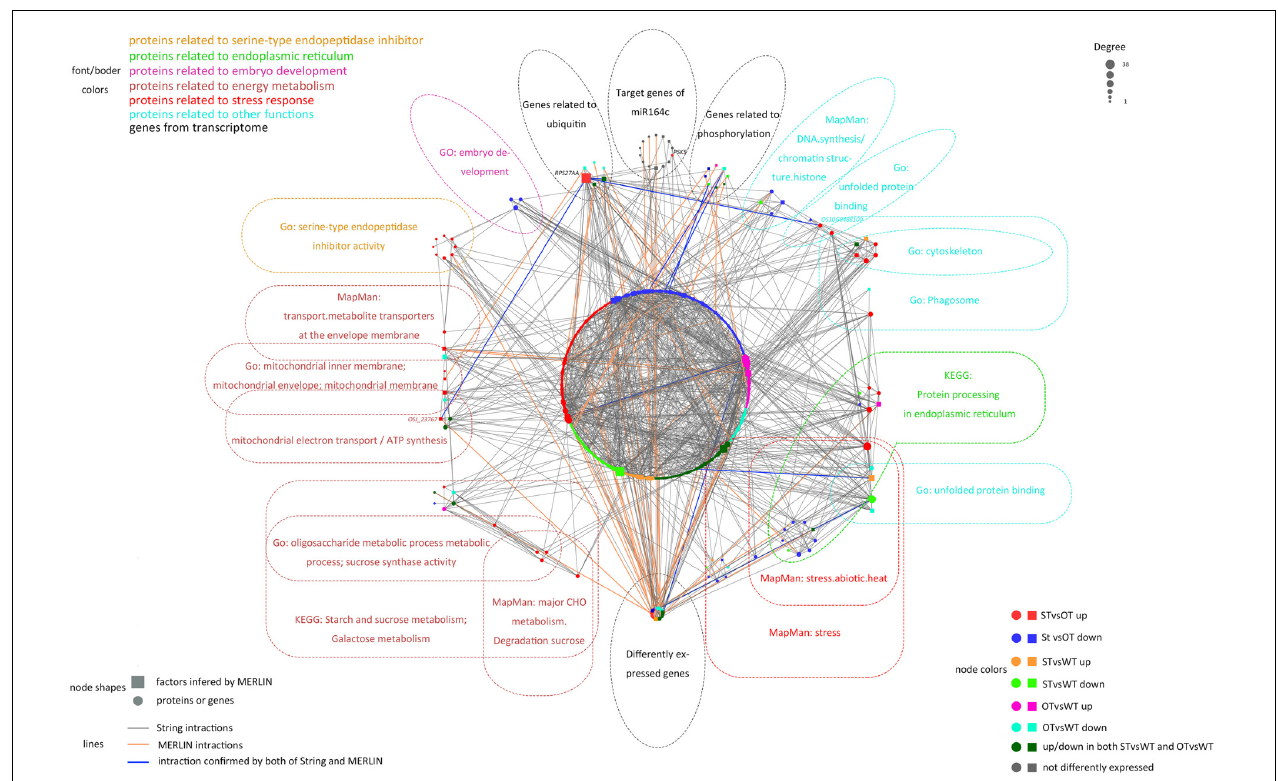
FIGURE 9 | Interaction between miR164c target genes and DEGs/DEPs identified in the transcriptome and proteome of WT, ST, and OT seeds. Colors of different boxes and the text within each box represent the major functional categories of genes or proteins. Colored nodes represent different types of regulation. Node shapes represent different types of genes or proteins. The node size represents the degree of nodes; the bigger the node size, the higher the degree. DEPs were identified based on the value of FC alone ( > 1.3 or < 1/1.3). DEGs were identified using thresholds for FC ( > 1.2 or < 1/1.2) as well as the P -value ( < 0.05). TABLE 1 | Ranking of hub genes in the gene/protein interaction network using cytoHubba.